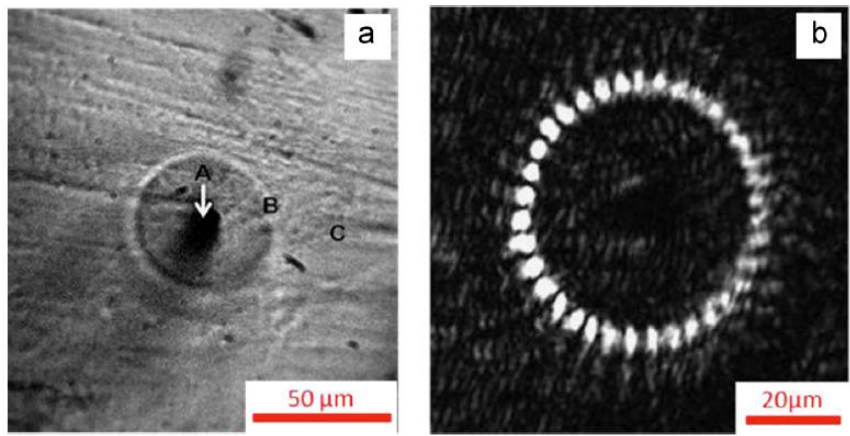
Figure 3. ( a ) Transmission optical microscopy image and ( b ) near-field intensity distribution of the output waveguide at 632.8 nm. [51]. Copyright (2014) Elsevier.